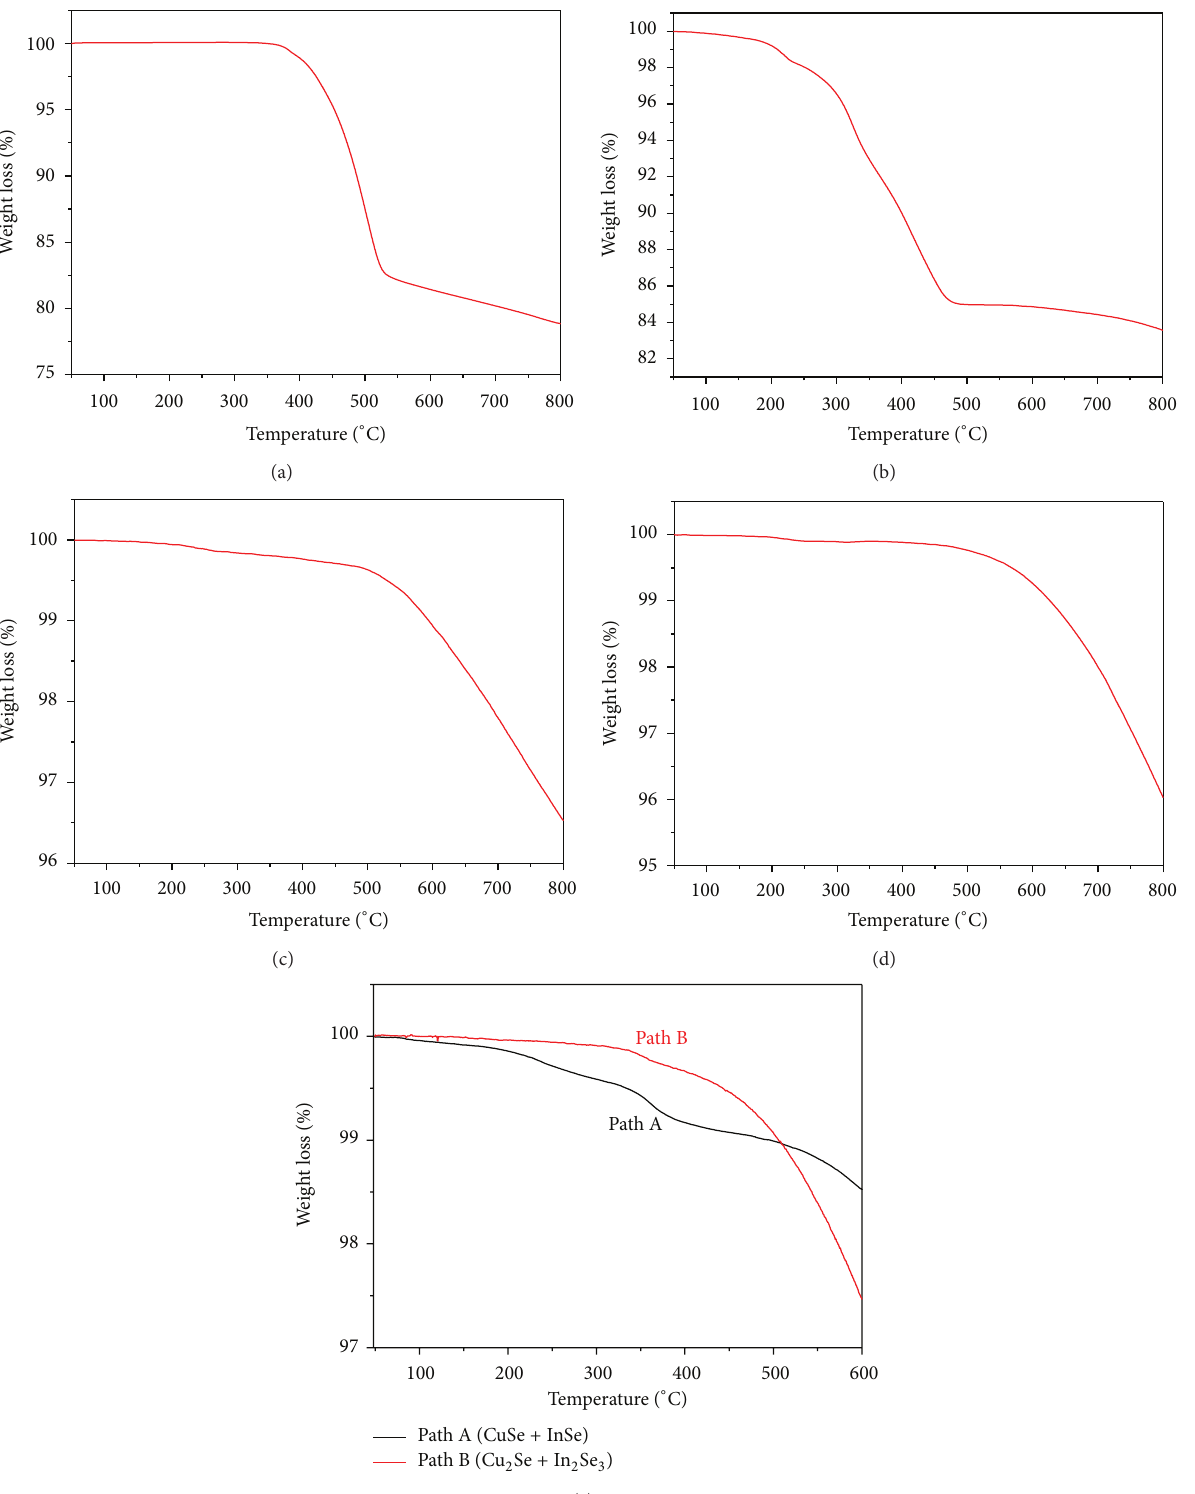
Figure 4: TGA curves of (a) CuSe, (b) InSe, (c) Cu 2 Se, (d) In 2 Se 3 , and (e) CIS particles prepared by the reaction path A or B via solid state